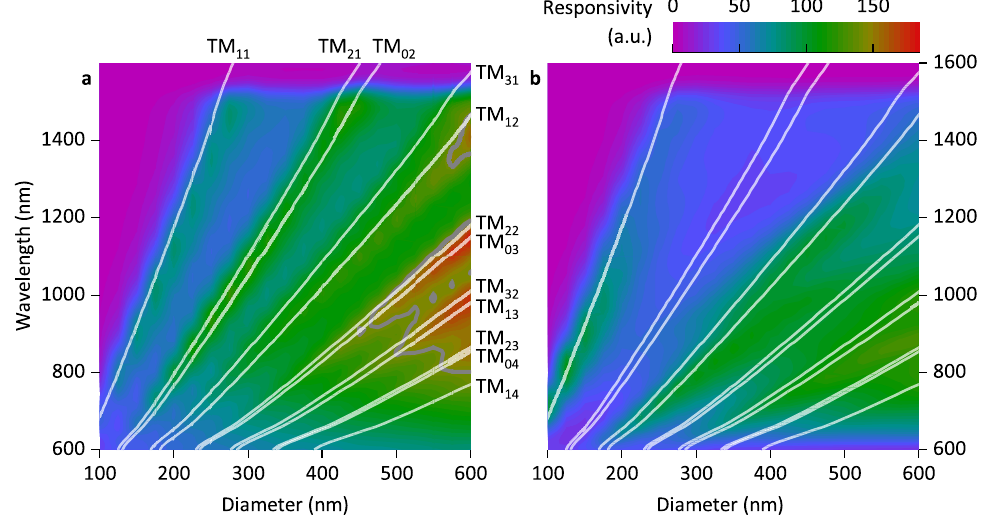
Figure 2. Simulated spectral responsivity (see Eq. 2 in the methods chapter) as a function of the diameter d NP of the NP-PD without metallization (Fig. 1c, d). The lines show the results obtained from solving Eq. 1. The illumination was chosen to be ( a ) parallel ( E 0 ‖ n , k 0 ⟂ n ) and ( b ) normal ( E 0 ⟂ n , k 0 ‖ n ) to the substrate plane ( n is the normal vector of the